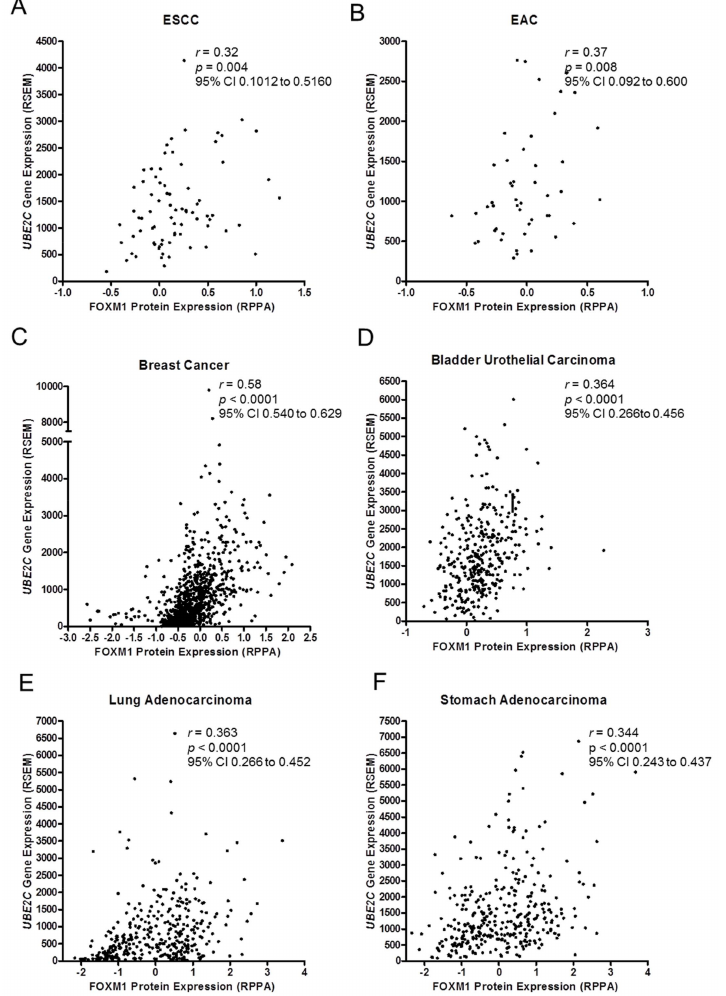
Figure 2. FOXM1 and UBE2C expressions are co-upregulated in cancer. Correlation analysis of FOXM1 protein and UBE2C gene expression from TCGA deposited data of different tumor types. A significant positive correlation between FOXM1 and UBE2C was observed in 77 ESCC ( A ); 48 esophageal adenocarcinomas (EAC) ( B ); 887 breast cancer samples ( C ); 340 bladder urothelial carcinomas ( D ); 360 lung adenocarcinomas ( E ); and 336 stomach adenocarcinomas ( F ). r : Spearman’s rank correlation coefficient; p : Spearman’s rank correlation p value; CI: confidence interval; RPPA: Reverse phase protein array units; RSEM: RNA-Seq by Expectation Maximization